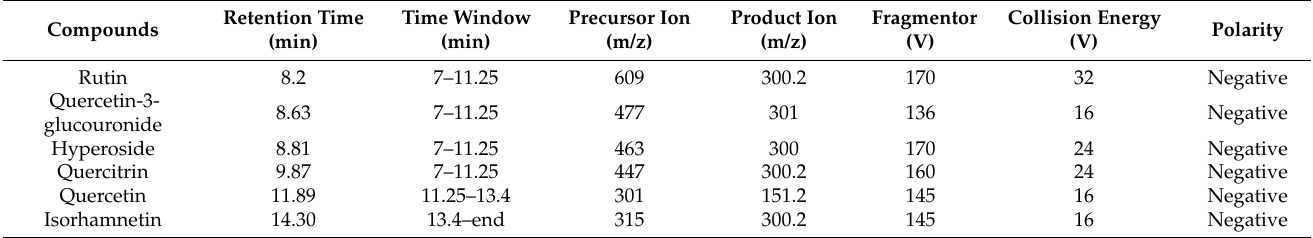
Table 2. Parameters acquired from the analysis in HPLC/MS-MS in MRM mode used for the analysis of quercetin and its